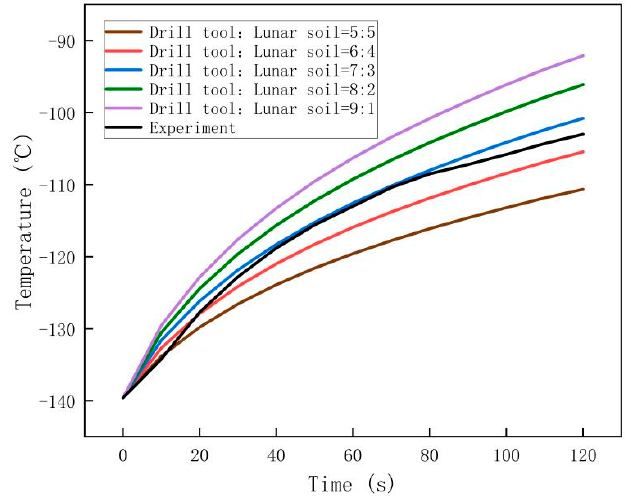
Figure 12. Comparison of simulation and experimental data regarding drill bit temperature in No. A1 under various distribution ratios.